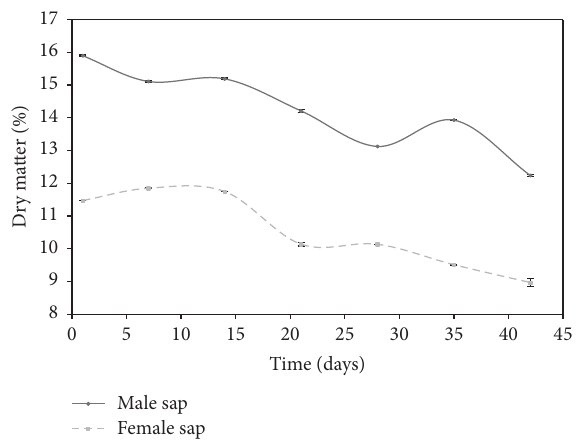
Figure 1: Variation of dry matter content of male and female date palm sap according to the collection